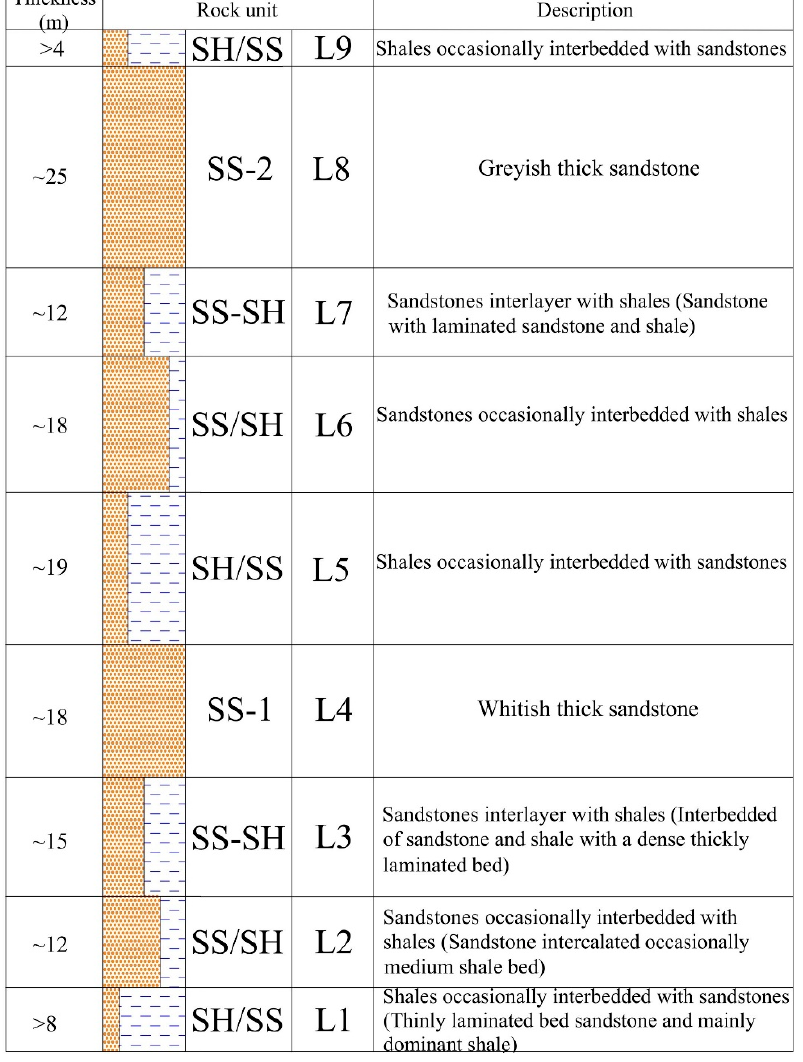
Figure 9. Stratigraphic column of the sedimentary rock in Mt. Dalun area, based on rock core analysis. The thickness of each rock unit was derived as the average thickness from the data of 26 boreholes.